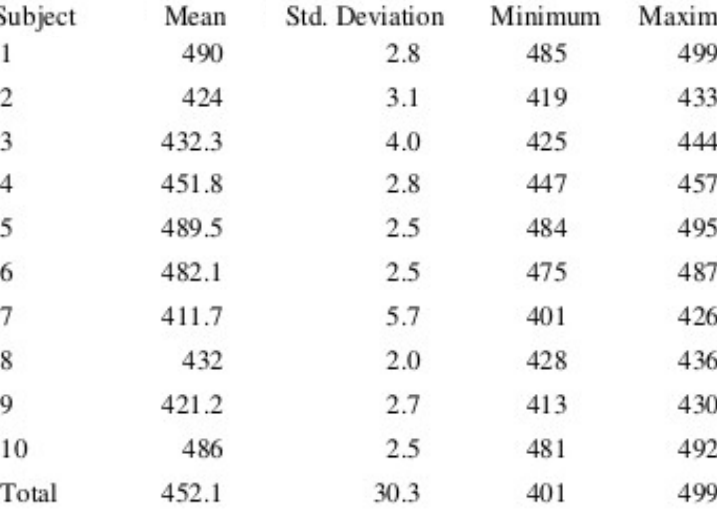
Table 1: Means, standard deviations, maxima and minima for CCT measurements in micrometres (µm) for the 10 subjects are given. A